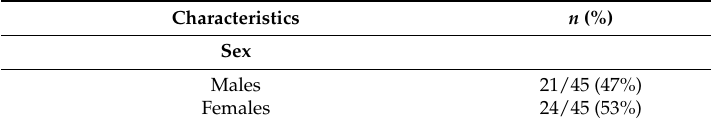
Table 1. Characteristics of Canadian children and adolescents (2–19 y) with sickle cell disease 1